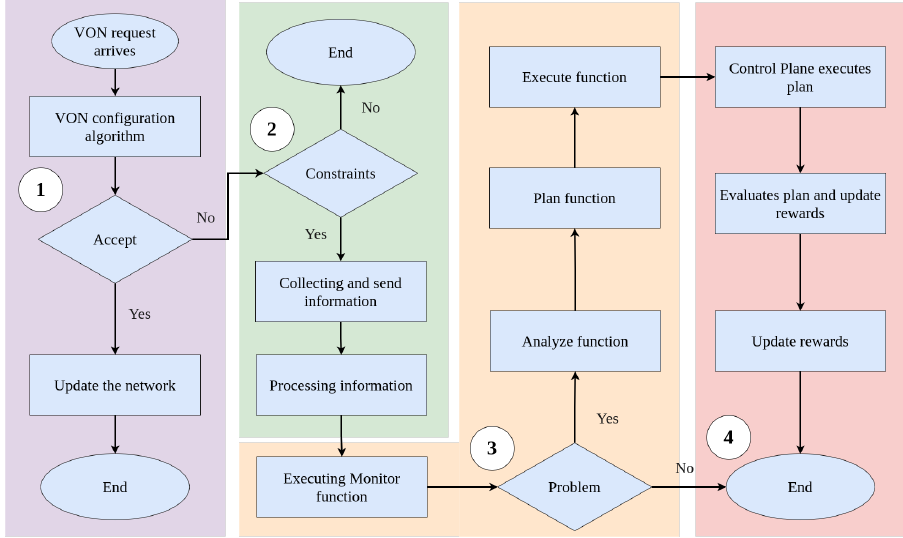
Figure 3. Illustration of how the CO-OP, control plane, and VON configuration algorithm are